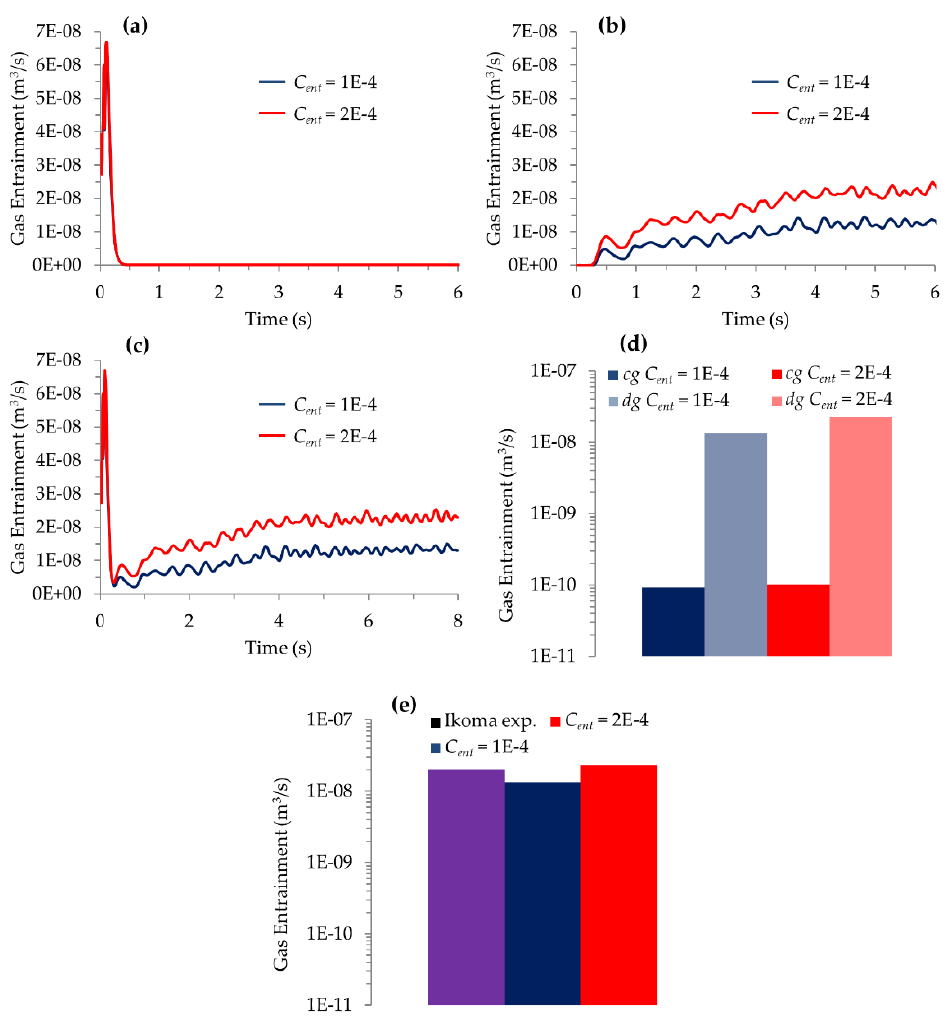
Figure 10. Transient profile of gas entrainment rate of: ( a ) potentially continuous gas, ( b ) dispersed gas and ( c ) total gas. ( d ) Average gas entrainment rate of cg and dg and ( e ) total. The results are obtained from the simulations using C scale = 1. The experimental gas entrainment rate is based on [71,72]. The velocity vectors represent the tangential projection of the liquid velocity on horizontal planes H1, H2, and H3, as presented in Figure 11. The background color represents the liquid vorticity magnitude. The influence of C ent on the magnitude of the rotation represented by the vorticity magnitude seems to be minor. For all the evaluation planes, no significant di ff erence can be observed from the simulation when using two di ff erent C ent